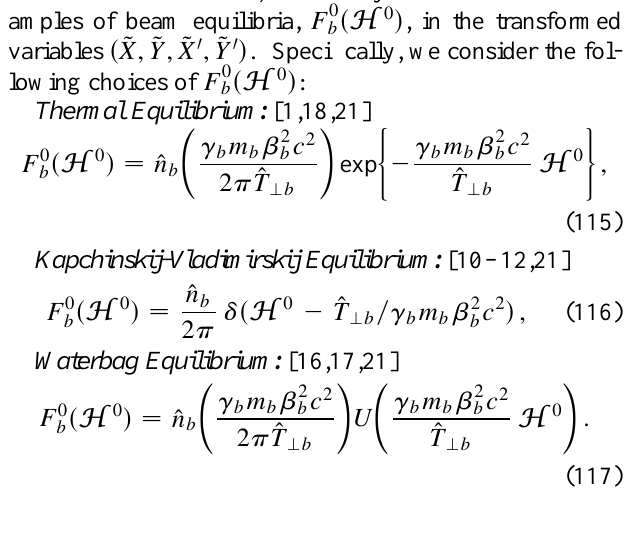
TABLE II. Equilibrium properties for various choices of F 0 b (cid:2) H 0 (cid:3) . Distribution